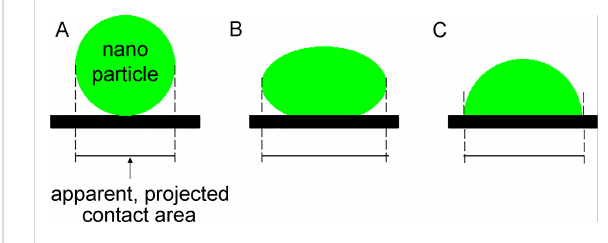
Figure 6: A nanoparticle (green) on a substrate (black) when the inter- action between the particle and the substrate is (A) very weak, (B) of intermediate strength and (C) strong.